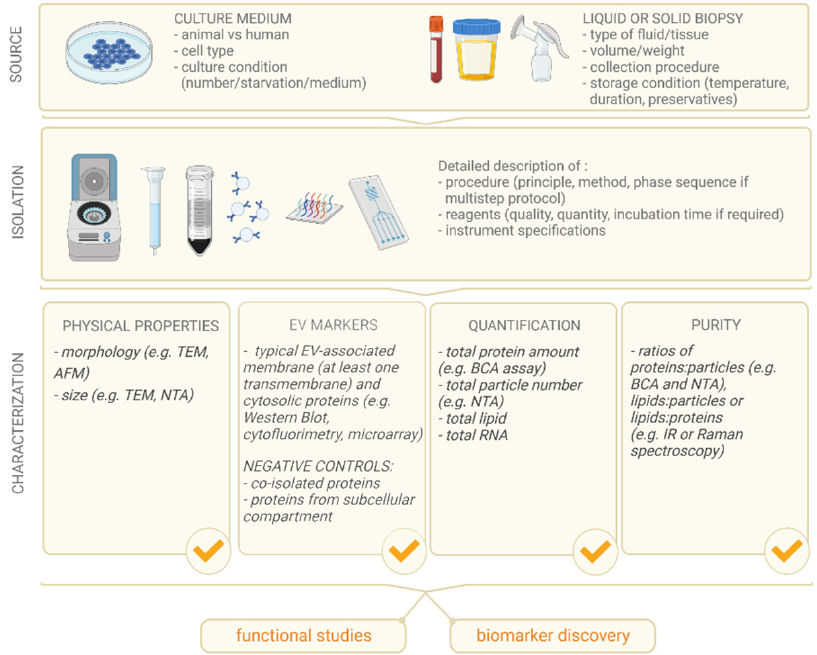
Figure 1. Schematic representation of the main MISEV2018 guidelines regarding the detailed description of the EV source, the isolation method used and/or developed and the general EV characterization. All these steps are crucial for (i) the reproducibility of the results, (ii) the reproducibility of downstream functional studies and (iii) the robustness of new suggested biomarkers.